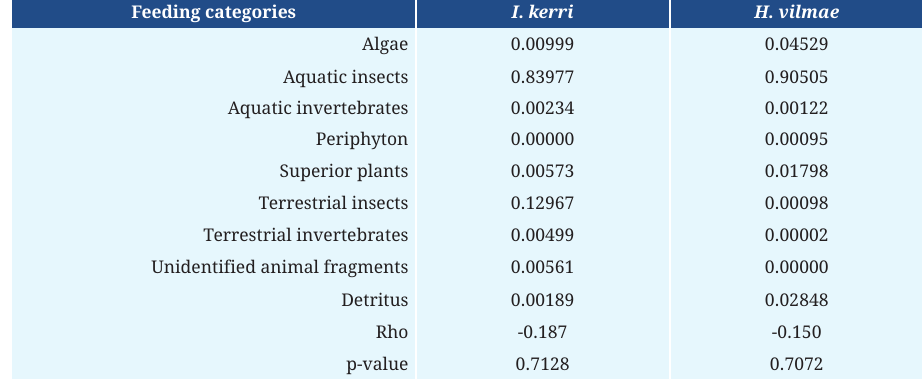
TABLE 3 | Alimentary importance index (IAi) of feeding items grouped into categories, and correlations (Rho) derived from RELATE routine between environmental variables and species’